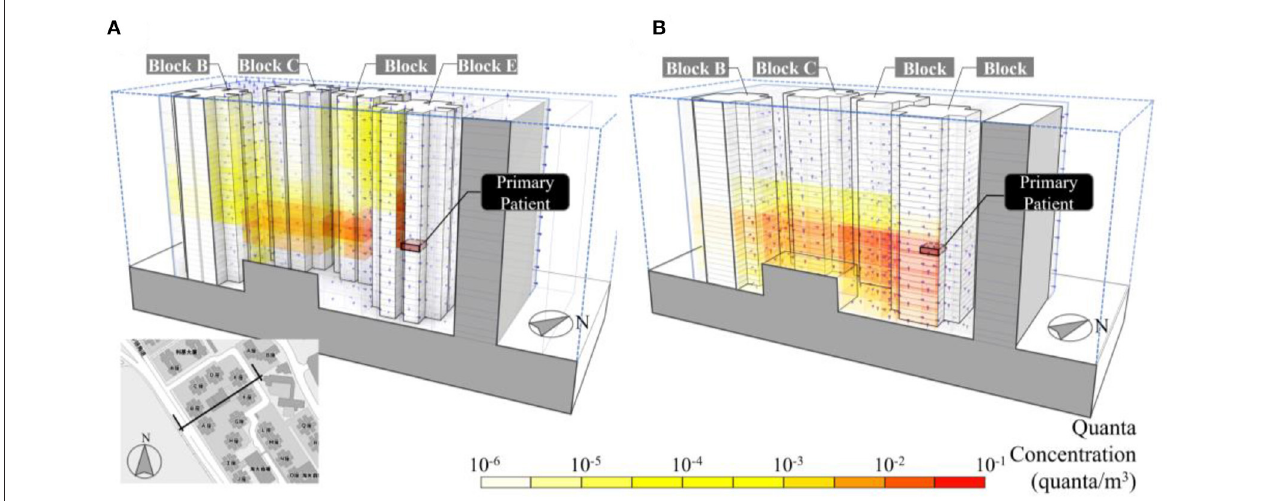
FIGURE 8 | (A) Predicted quanta concentration in Amoy Gardens, Hong Kong during the SARS outbreak in 2003 using ATOR including the reentrance space between Apt.7 and Apt.8 in Block E in the model domain and (B) s imulated vial air load concentration without buoyancy force, in which the viral plume bend downward by the “wake effect.”